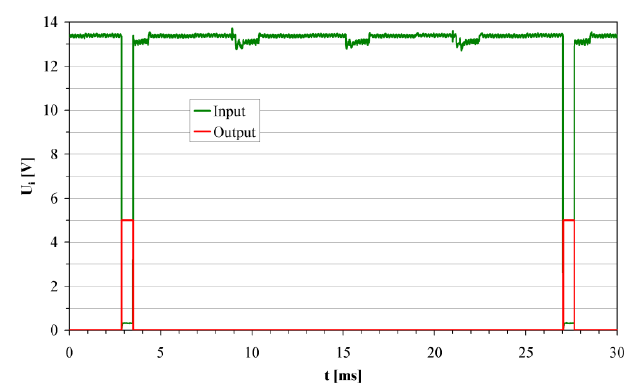
Fig. 6. Signal conversion to a rectangular form with 5 V amplitude limita- tion and phase reversal